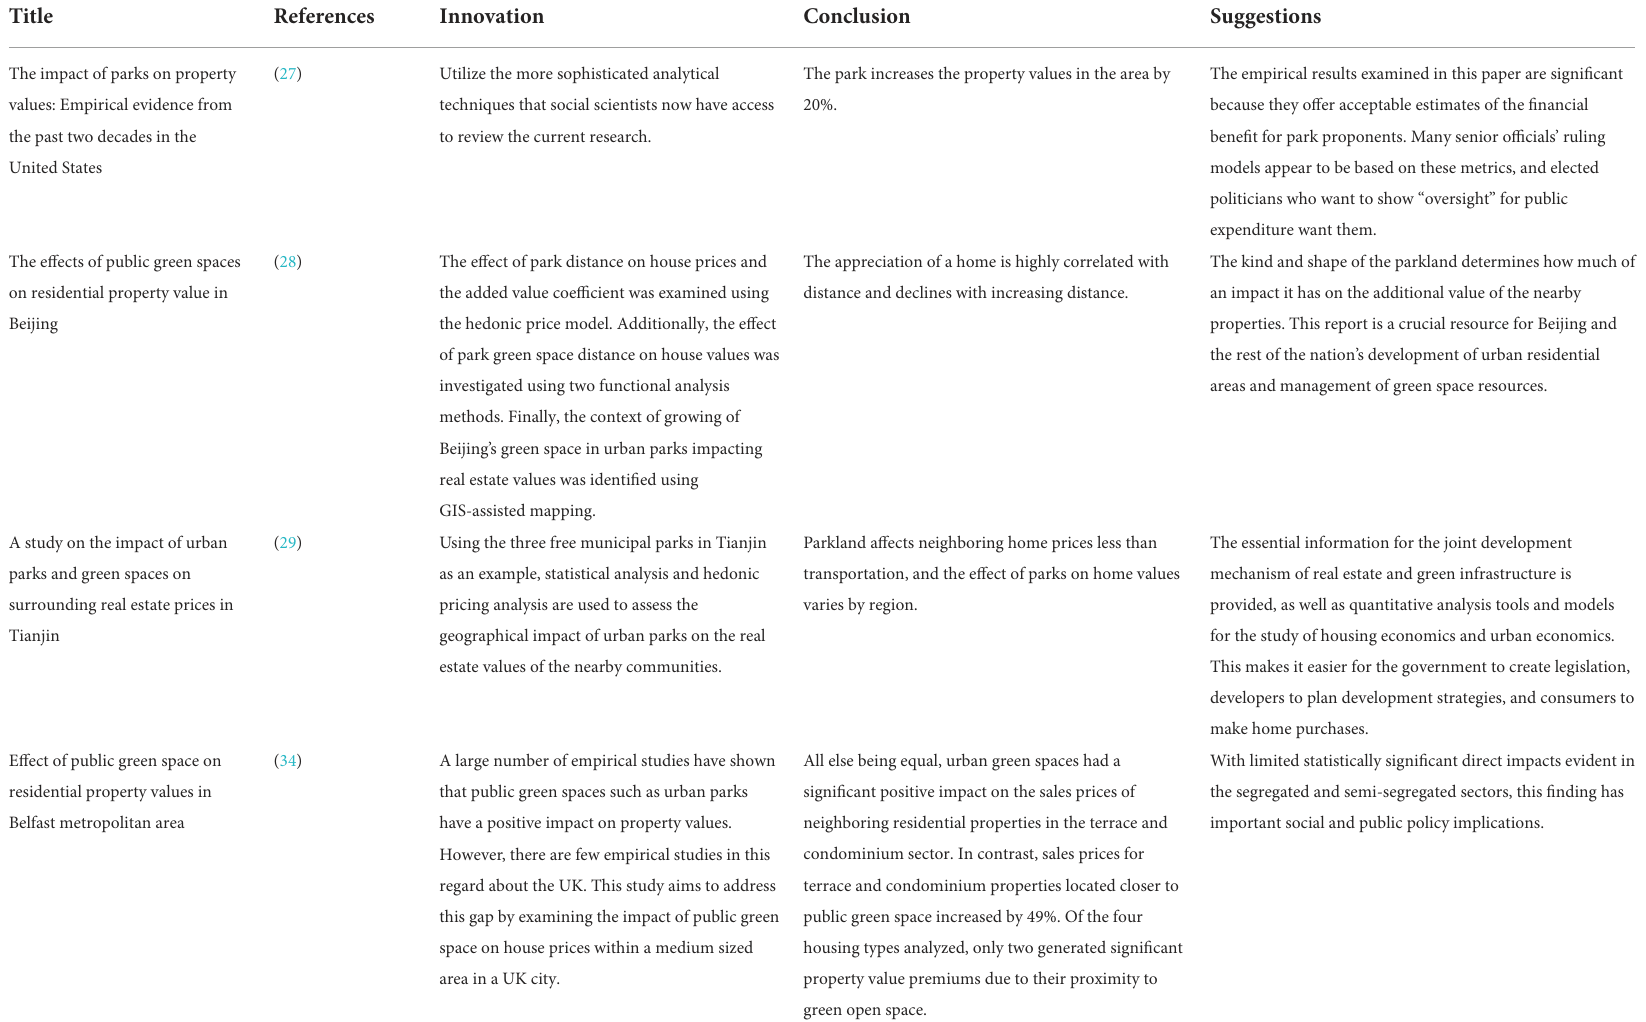
TABLE 4 Literature review of the variability on the impact of the same park green